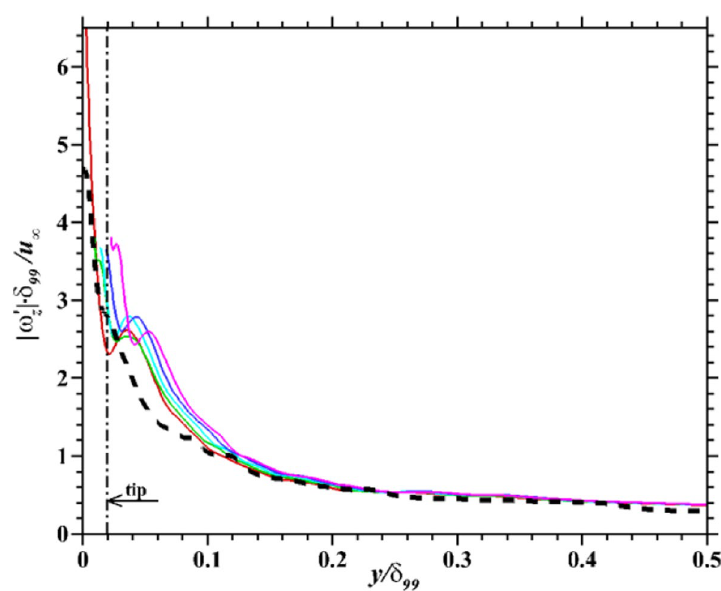
Table 1 Comparison of the peak magnitude and position of the vorticity fluctuation in three directions Peak magnitude and maximum offset Smooth flat-plate case Riblets flat-plate case Smooth flat-plate case Riblets flat-plate case Wall-normal